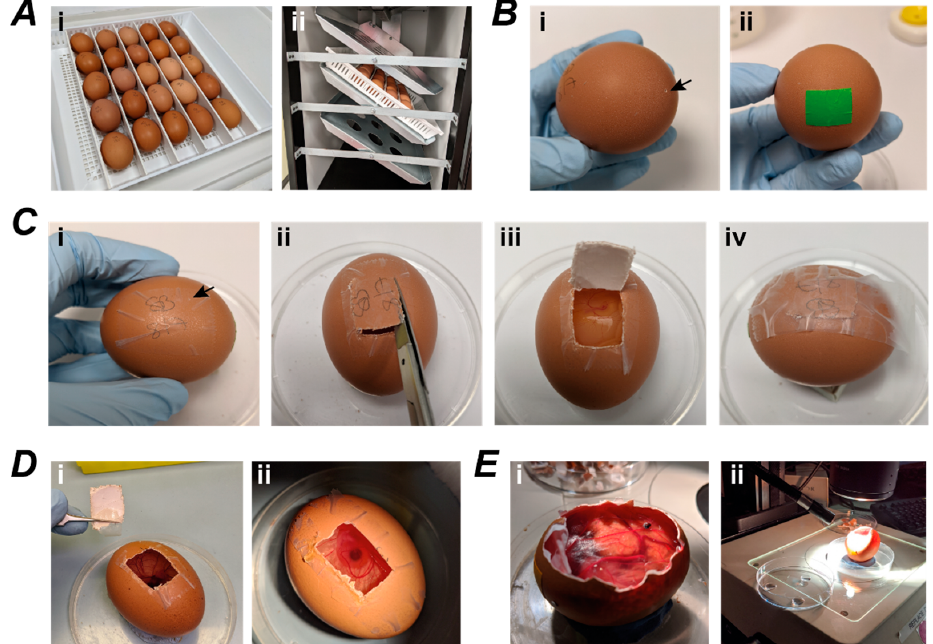
Figure 2. Workflow for MPM cell engraftment on the CAM. ( A ) Fertilised eggs are placed horizontally in white trays (i) and incubated at 37 °C to initiate embryonic development. Trays are rotated 45° every 45 min to prevent membranes sticking to the shell (ii); ( B ) Prior to windowing on embryonic day 3 (E3), a hole is made in the wide base of the egg (i; arrowhead) to allow 5 mL albumin to be removed and then sealed with Nev’s label tape (ii); ( C ) To create the window, a hole is pricked in the eggshell as a starting point (arrowhead) and a piece of Scotch tape placed over the area where the window is to be cut (i). Scissors are used to the cut the window (ii) leaving one side attached (iii). The window is then sealed shut with Scotch tape (iv); ( D ) Cells are implanted on E7 by removing the window (i) to expose CAM underneath (ii). Once cells have been added to the CAM, the window is sealed shut again (Civ); ( E ) At E14 the window is enlarged (i) to allow inspection of the embryo and imaging of tumour nodules (ii).